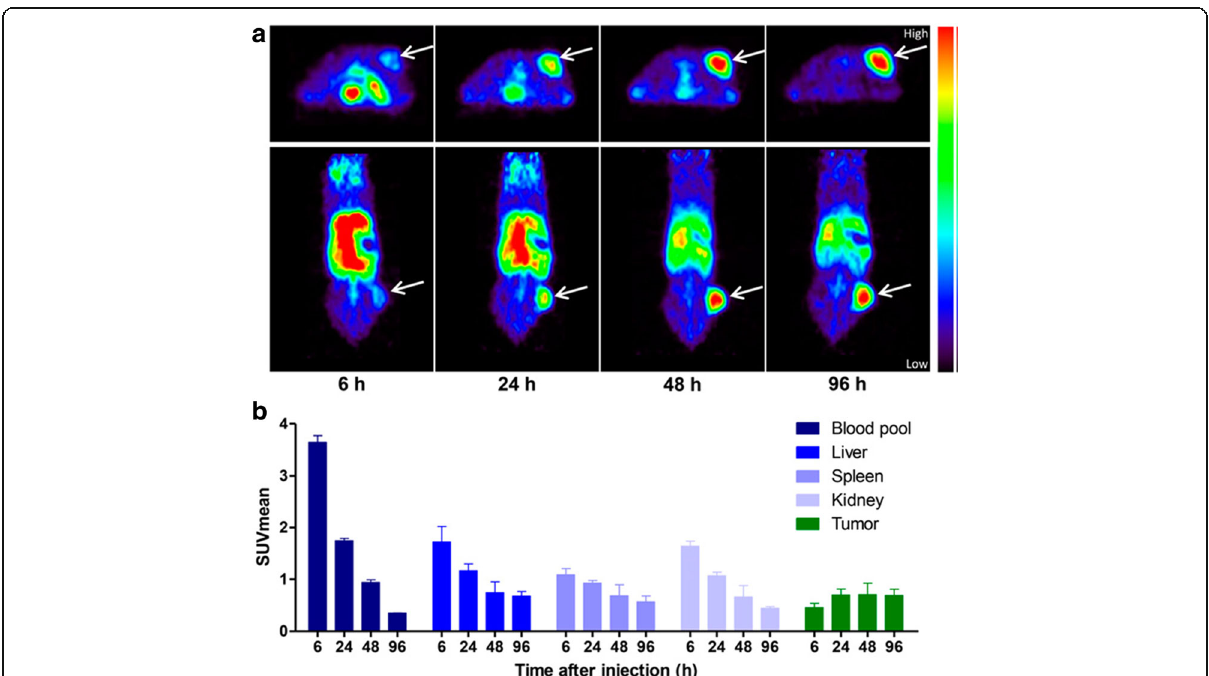
Fig. 4 89 Zr-PRS-110 micro-PET imaging of H441-bearing mice. a Transversal and coronal micro-PET images of the mice are shown at different timepoint post-injection of tracer. b Micro-PET data quantification expressed as mean standardized uptake value (SUVmean) was performed for normal organ and tumor in all mice. With permission from reference